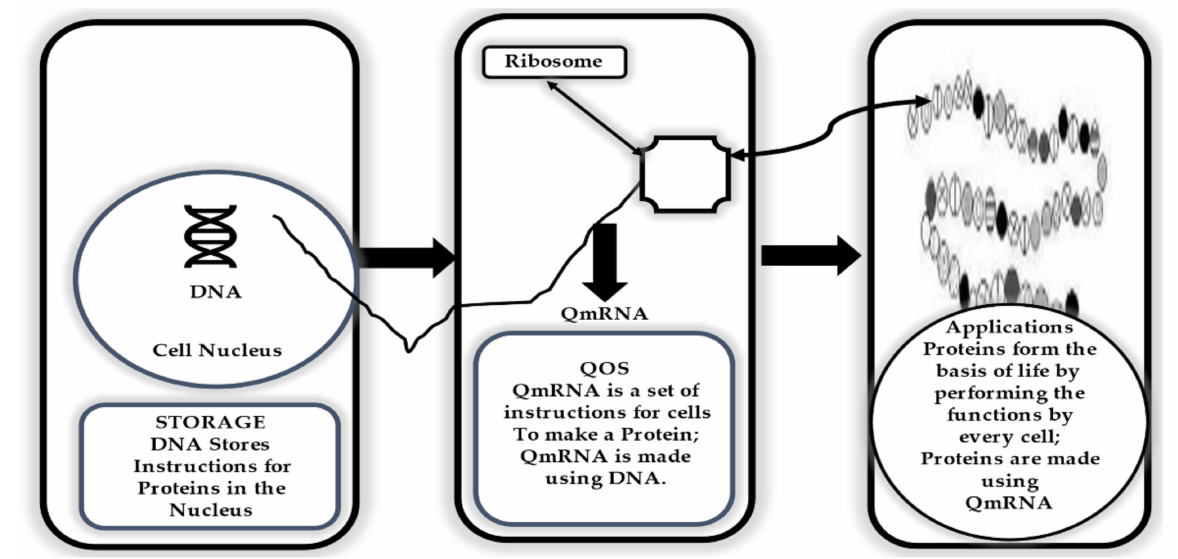
Figure 3. Quantum operating system (QOS) for mRNA science and technology platform.